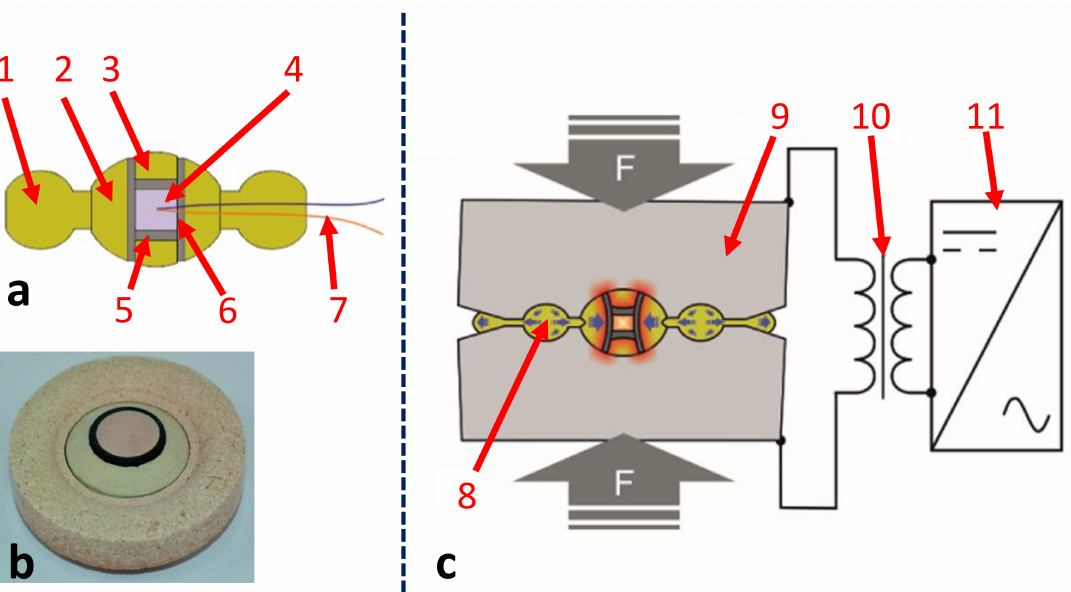
Figure 8. HP-SPS device at the Institute of Advanced Manufacturing Technology (at Krakow) in Poland. Cross section ( a , c ) and photography ( b ) of the high-pressure reaction chamber and HP-SPS device schematic, where: 1—ceramic gasket (outer part); 2—ceramic gasket (inner part); 3—ceramic disc; 4—sample; 5—graphite disc; 6—graphite tube; 7—thermocouple (used only for temperature calibration). Quasi-isostatic compression of the preliminary consolidated powders is achieved as a result of plastic deformation of the gasket material (8) between anvils (9); electrical heating during HP-SPS process is provided by transformer (10), together with inverter (11), thus providing 1 kHz direct pulsed current. Adapted from [57,58].